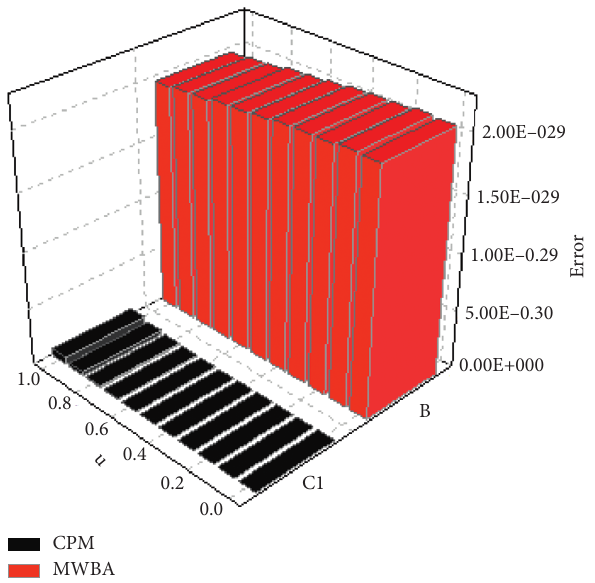
Figure 10: Error graph of MWBA and CPM for problem 4.